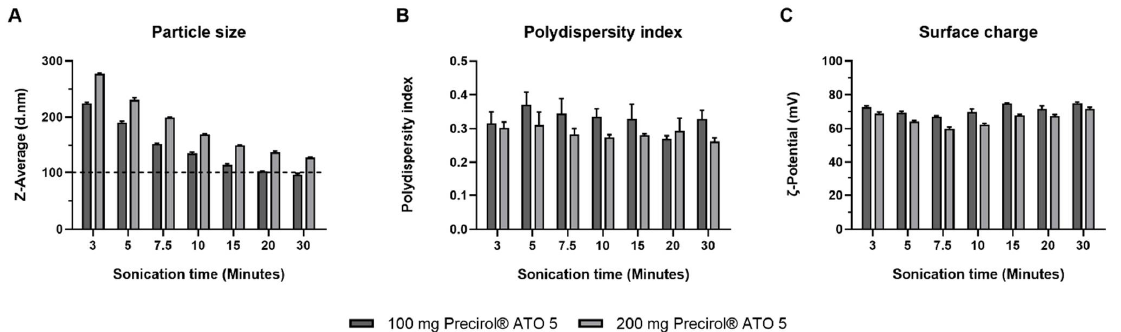
Figure 1. Optimization of the preparation process of SLNs. ( A ) Particle size, ( B ) polydispersity index and ( C ) surface charge of SLNs prepared with 100 or 200 mg of Precirol ® ATO 5 at different sonication times. Results are shown as the mean ± standard deviation ( n = 3). Horizontal discontinuous line refers to a particle size of 100 nm.